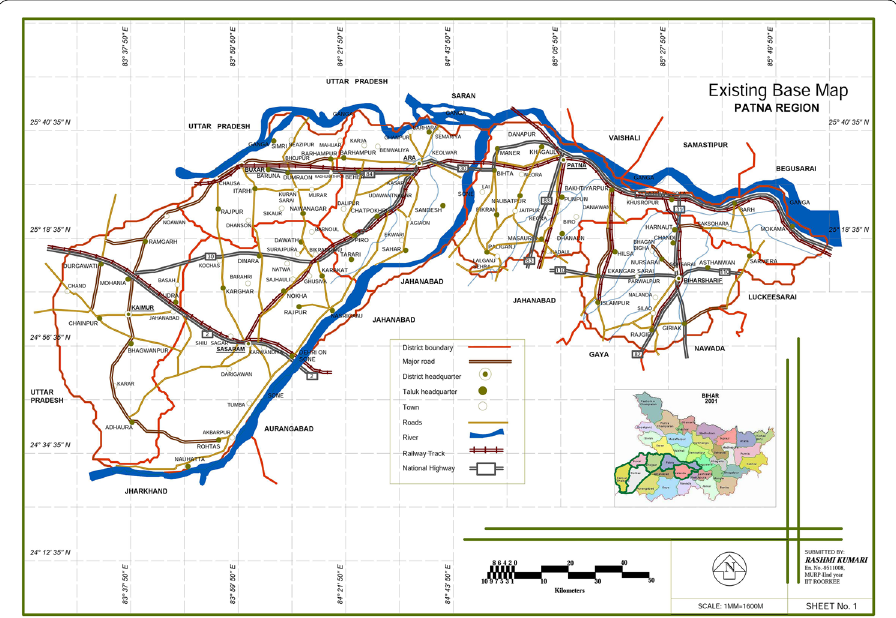
Fig. 3 Map of Patna region. Existing base map of the study area, Patna region,